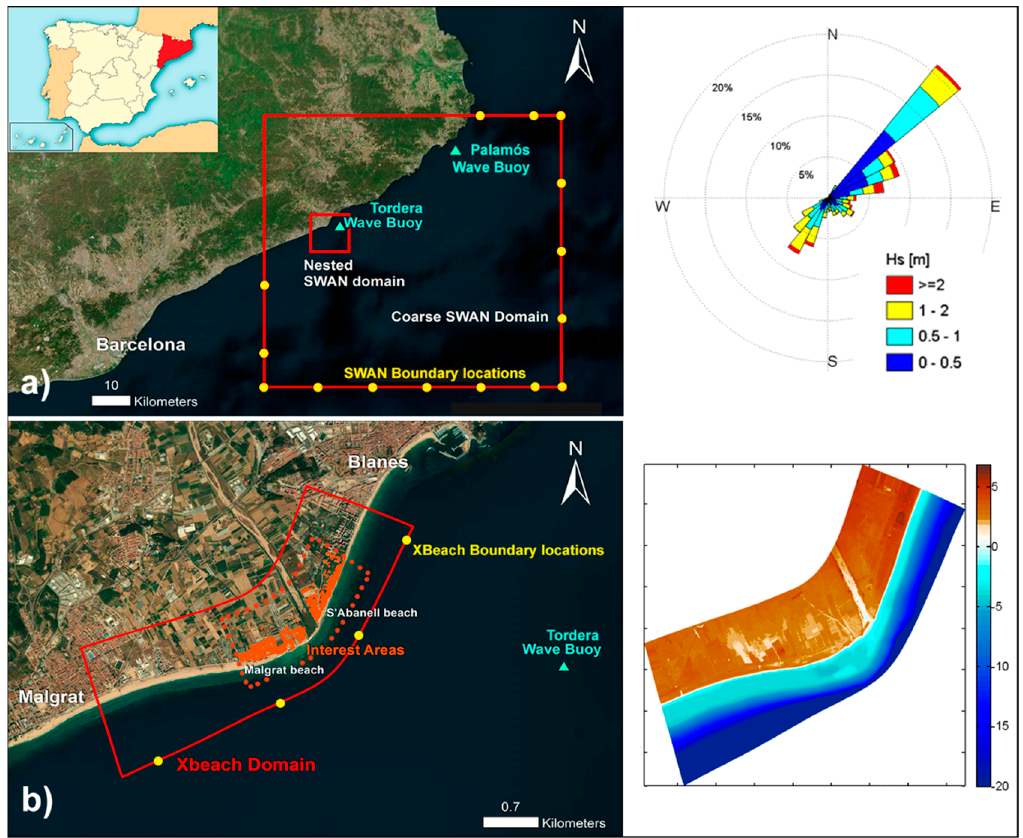
Figure 1. Tordera Delta study area, location and model set-up. ( a ) SWAN (Simulating Waves Nearshore) grids (red) with boundary wave-spectrum nodes (yellow), wave buoys (blue triangles), and significant wave height wave rose for the period 1948–2009 (Global Ocean Waves, GOW, Reguero et al. [33]) at the Tordera wave buoy location. ( b ) XBeach set-up, curvilinear grid domain (red) and interest areas (orange) and pre-storm topobathymetry.